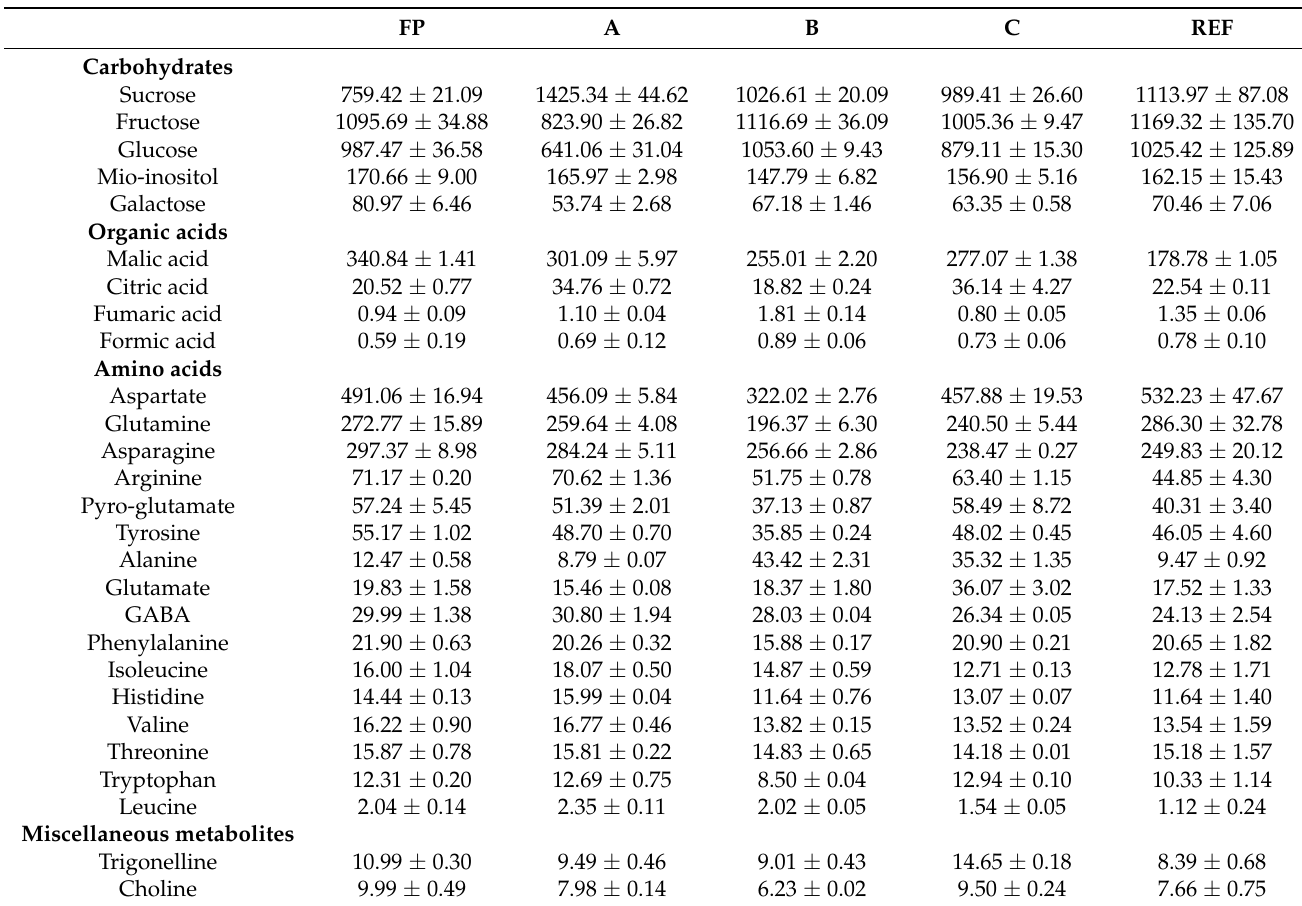
Table 3. Carbohydrate, organic acid, amino acid and other metabolite amounts (mg/10 g ± SD) by NMR analysis of the pumpkins Bligh–Dyer hydroalcoholic fractions reported for fresh and packaged pumpkin samples. FP = fresh pumpkin